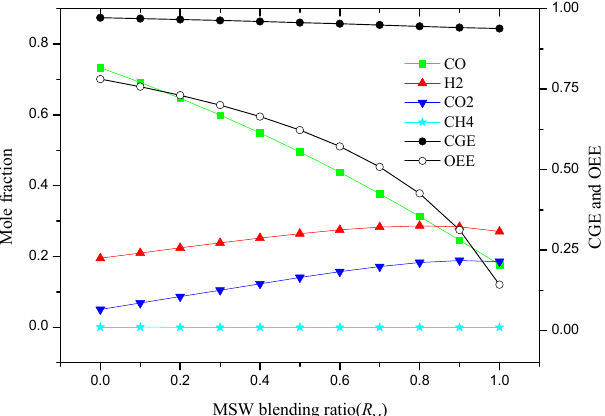
Figure 6. E ff ect of R M on raw syngas composition and system performance ( T = 900 ◦ C; R o = 0.2; and Figure 6. Effect of R M on raw syngas composition and system performance ( T = 900 °C; R o = 0.2; and R c = R c = 0.5).